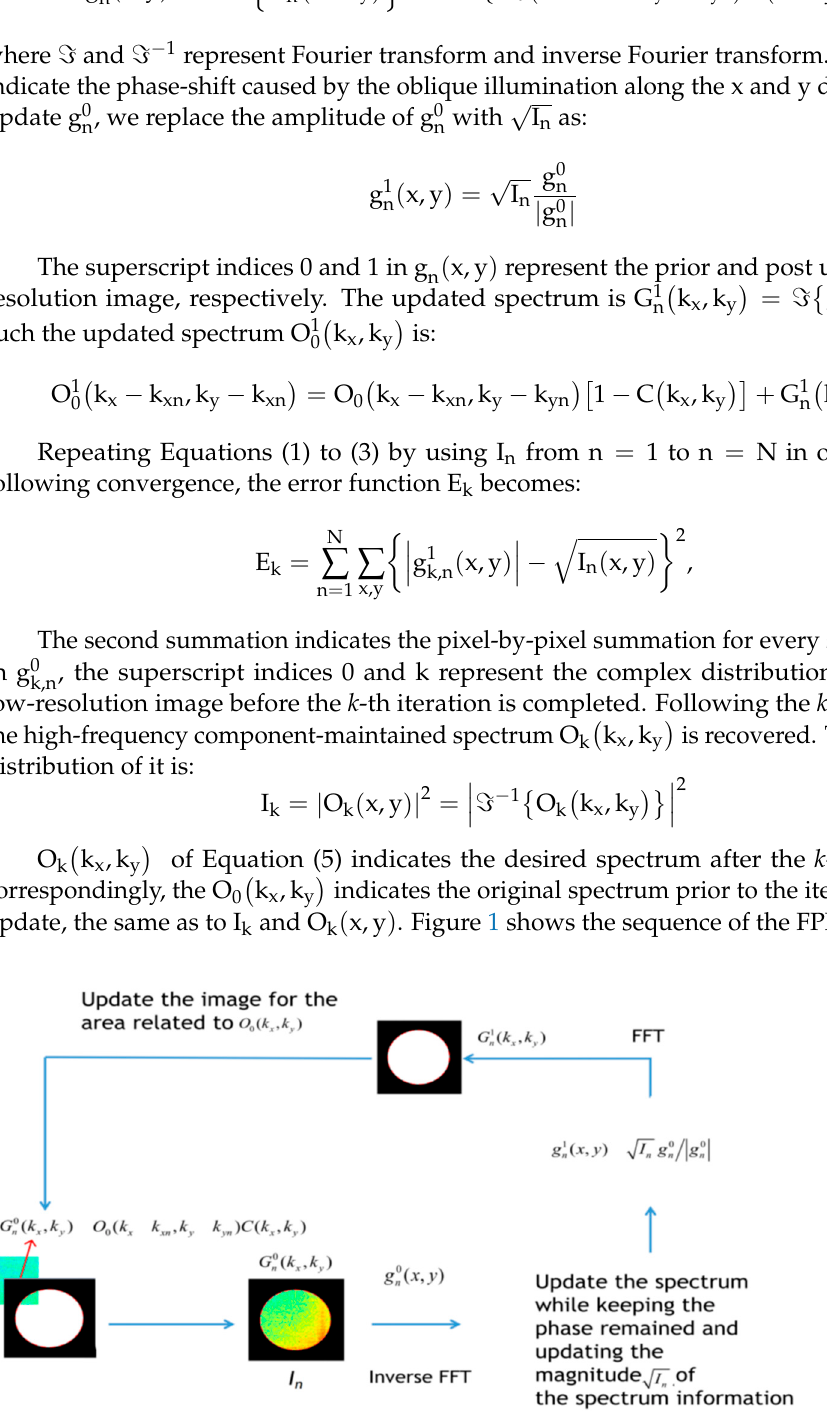
Figure 1. The iteration process of FPM. In the iteration, the sampling rate of the initial guess of the high-resolution object is higher than the collected low-resolution images. Through the iterative process, the reconstructed image is increased in spatial resolution.